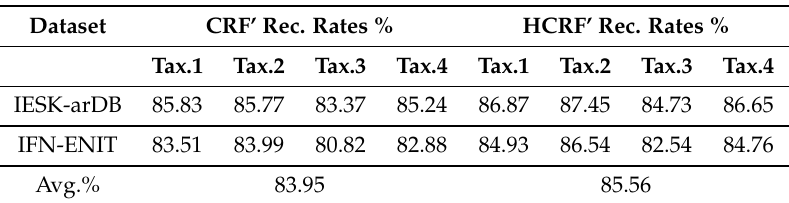
Table 2. Letter-based performance of CRF and HCRs across the IESK-arDB and IFN-ENIT databases for the four-letter